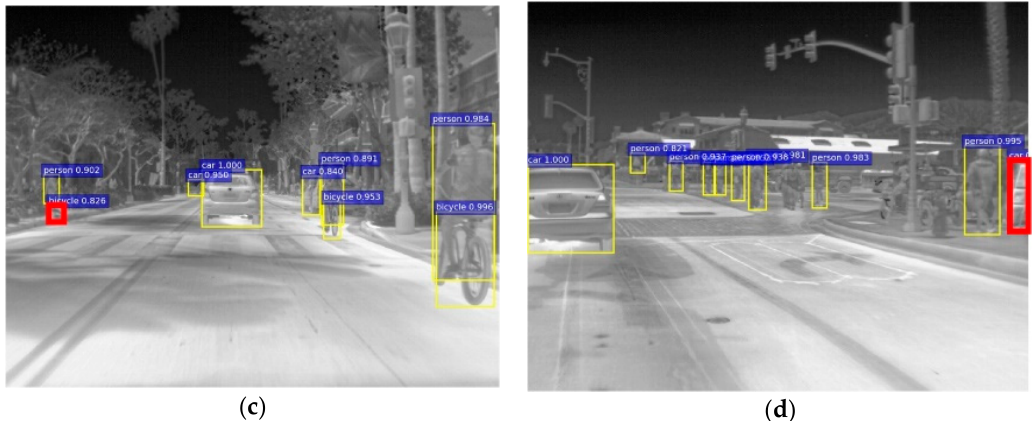
Figure 6. False alarms occur under complex circumstances. Red lines indicate errors. Yellow lines indicate correct detections.